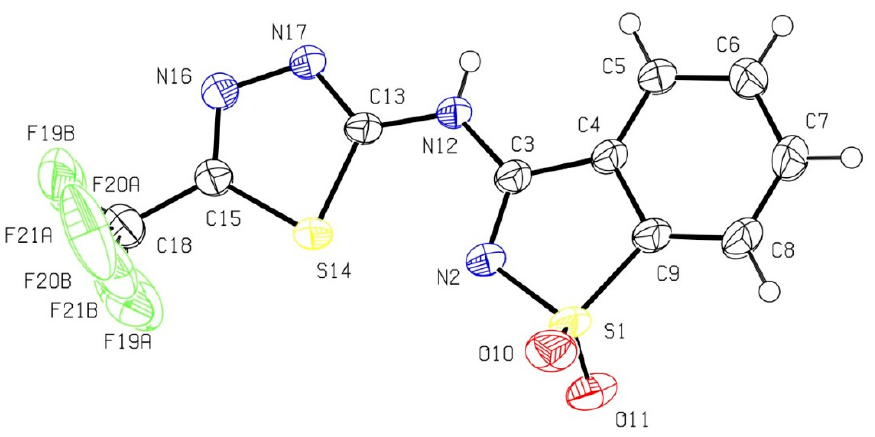
Figure 2. ORTEP (Oak Ridge Thermal Ellipsoid Plot) drawing of the molecule of AL14. The anisotropic displacement ellipsoids are drawn at the 50% probability level.